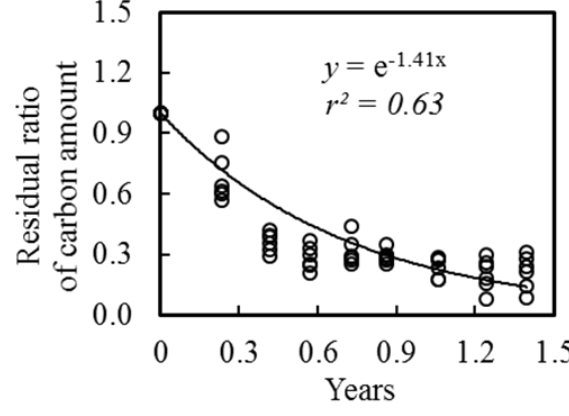
Figure 5. Pattern of C loss from pruned fronds. Table 3. Net primary production (NPP) in terms of biomass and carbon.